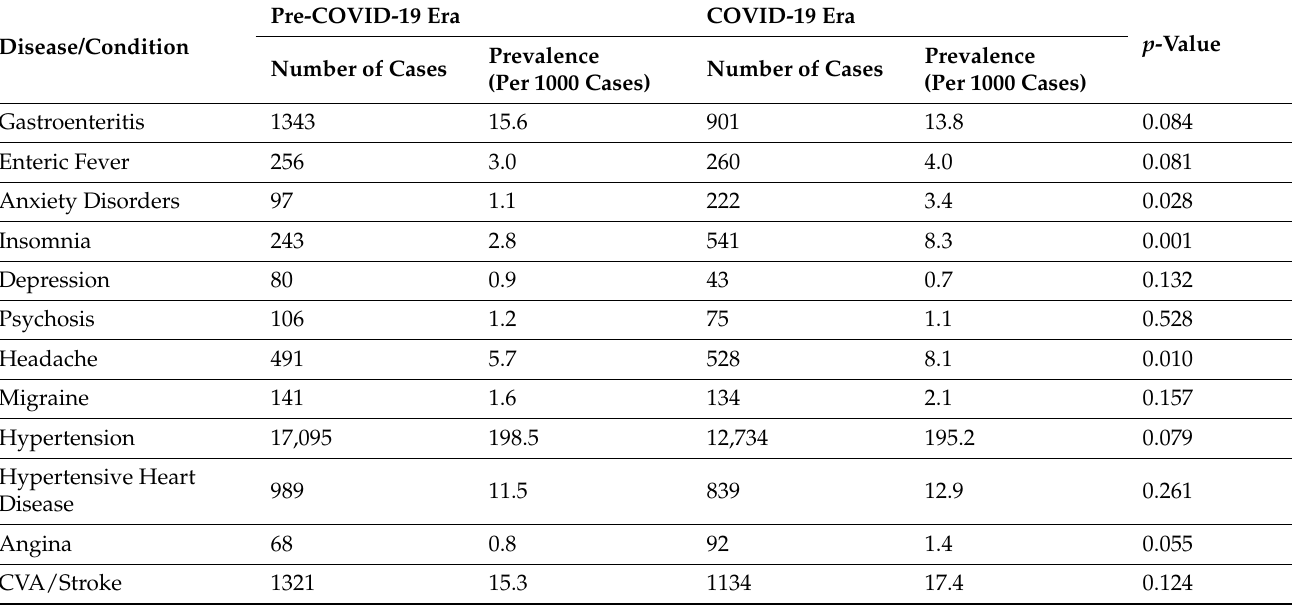
Table 6. Differences between the prevalence of the various diseases in the pre-COVID-19 and COVID- 19 eras.